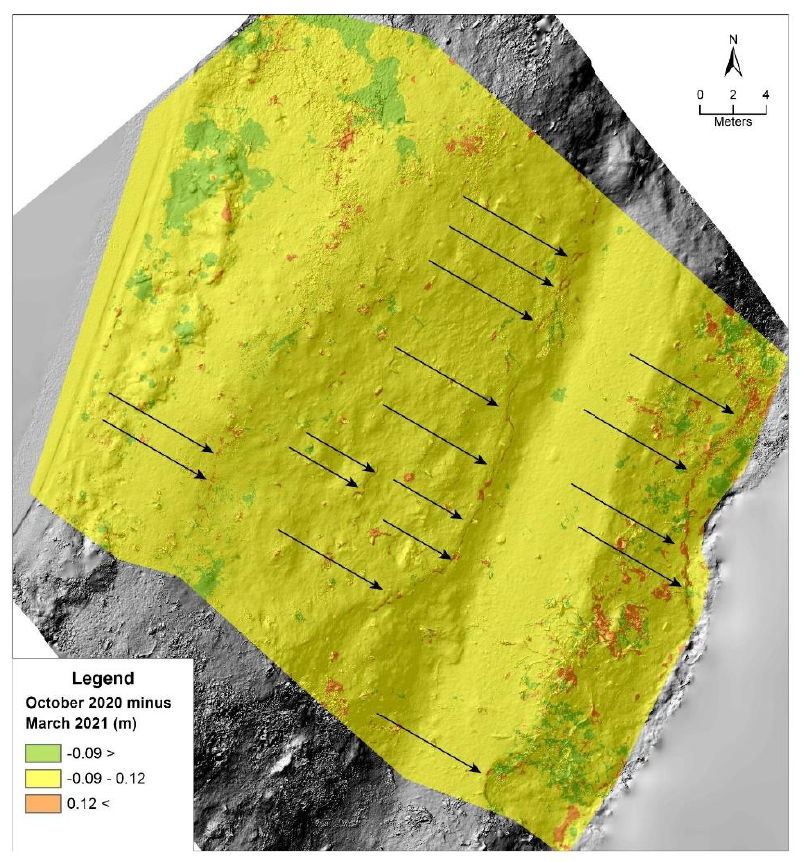
Figure 6. Differences between the October 2020 and the March 2021 UAV–derived DSM from Kechries site one: The pre-existing scarp at the eastern part of the slope is now further expanded, while another major crack is visible in the central part of the slope. In addition, further smaller cracks parallel to the two larger ones are traced in the western part of the slope. Black arrows indicate possible cracks in the soil surface.